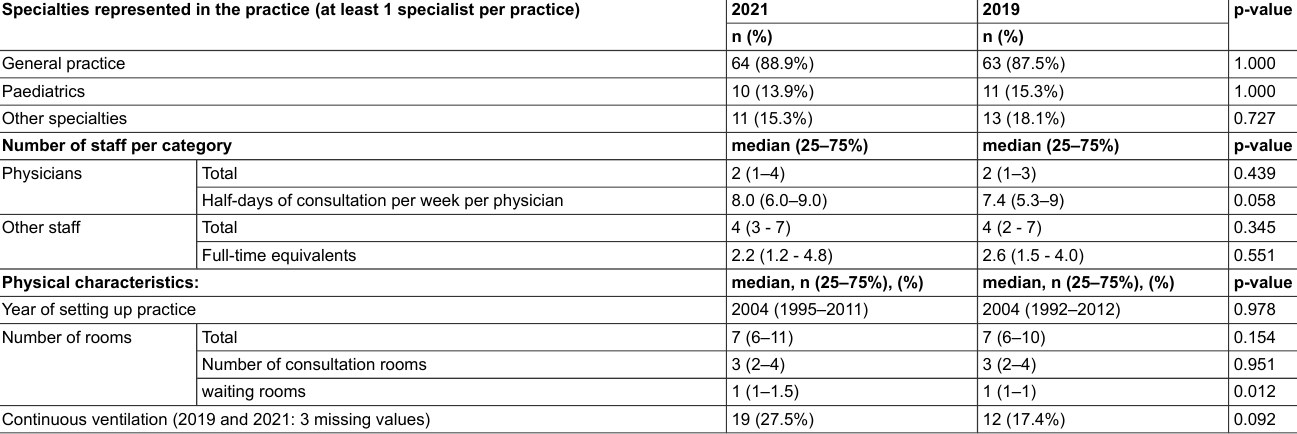
Table S2: Characteristics of Sentinella network practices with data for both 2021 and 2019 surveys (72 answering practices). Paired analysis with p-values from exact McNemar test (pro- portions) and Wilcoxon signed rank test (counts or